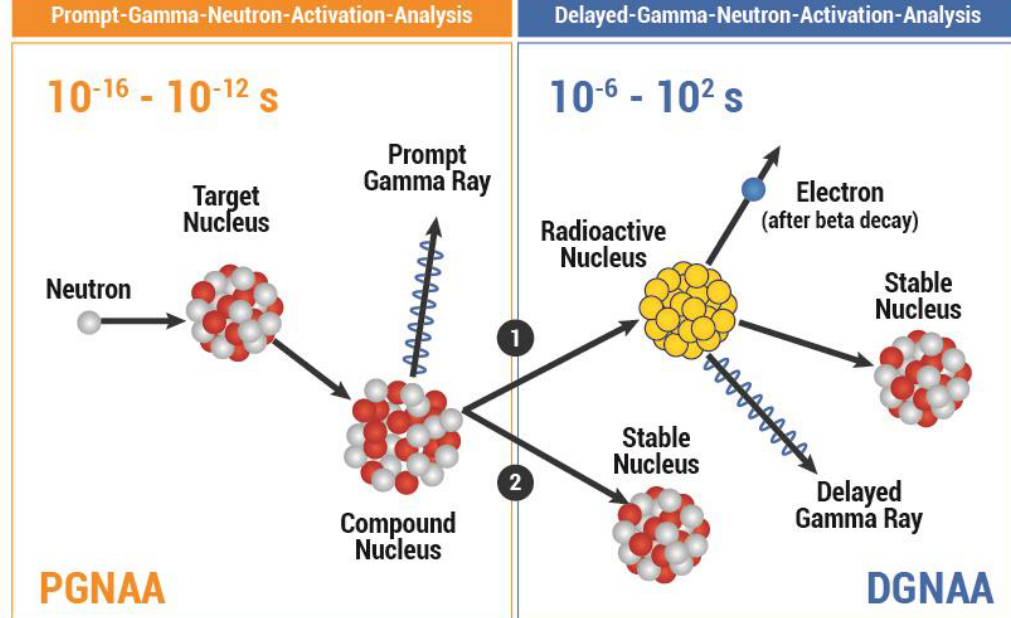
Figure 1: Physical basics of Prompt and Delayed Gamma Neutron Activation Analysis